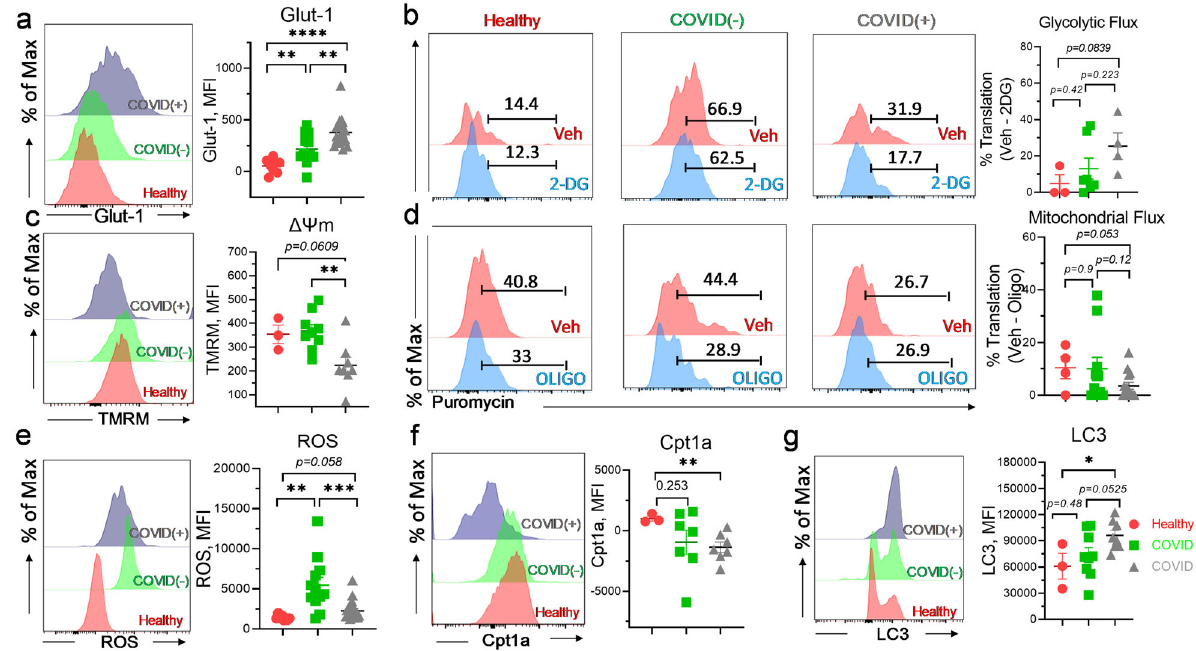
Fig. 2 Metabolic dysfunction is evident in CD8 + Tc from severe COVID-19 patients. Freshly isolated PBMCs were evaluated by fl ow cytometry. a Representative histogram and summary graphs demonstrating glut-1 expression in CD8 + Tc from healthy, COVID( − ), and COVID( + ) patients ( n = 8 HD, 12 C − , 20 C + ). b Representative histograms and summary graph demonstrating glycolytic fl ux of CD8 + Tc from healthy, COVID( − ), and COVID( + ) patients using SCENITH ( n = 3 HD, 7C − , 4 C + ). c Representative histogram and summary graph demonstrating ΔΨ m, mitochondrial membrane potential (TMRM), in CD8 + Tc from healthy, COVID( − ), and COVID( + ) patients ( n = 3 HD, 9 C − , 8 C + ). d Representative histograms and summary graph demonstrating mitochondrial fl ux of CD8 + Tc from healthy, COVID( − ), and COVID( + ) patients by SCENITH assay ( n = 4 HD, 10 C − , 14 C + ). e – g Representative histogram and summary graphs demonstrating the levels of ROS ( n = 8 HD, 12 C − , 20 C + ) ( e ), cpt1a ( n = 3 HD, 7 C − , 7 C + ) ( f ), and lc3 ( n = 3 HD, 9 C − , 8 C + ) g in CD8 + Tc from healthy, COVID( − ), and COVID( + ) patients. c , d , g Three samples were excluded from the analysis due to critically low CD8 + Tc count; in b , one sample was excluded from analysis due to critically low CD8 + Tc count. Two-tailed student ’ s t test was used. * p < 0.05, ** p < 0.01, and *** p <